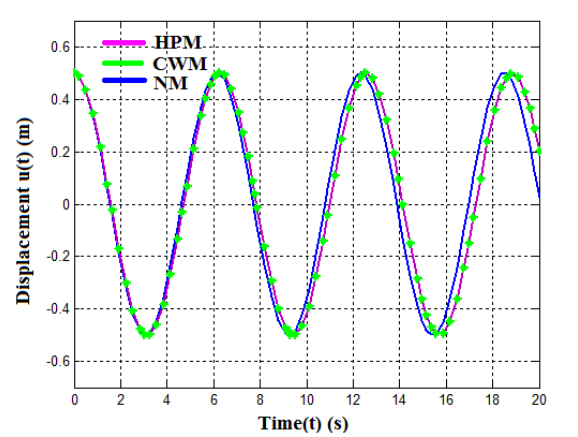
Fig. 5 Comparison of CWM (Eq. (44), HPM (Eq. (45) and numerical method (MATLAB result) for fixed parameter values l = 0 . 5 , ς = 0 . 2 .